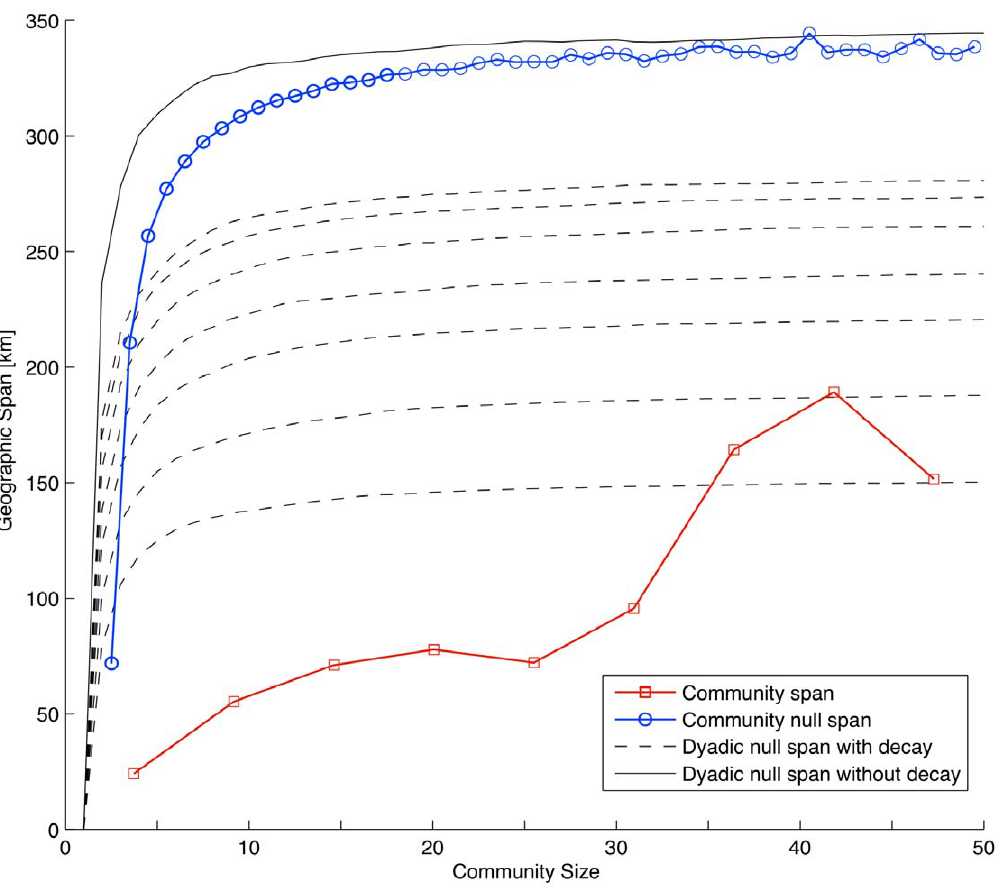
Figure 4. Average observed geographic community span D (red) and average geographic community null span D c (blue). The dyadic null span with decay, denoted by D d , incorporates the decay of the connection probability as a function of distance for various values of the scale parameter, shown as dashed lines. The solid black line is the dyadic null span without decay. Both are measured in kilometers. We observe large deviations from both null models, which can be quantified as the areas between the empirical curve and any of the null curves.